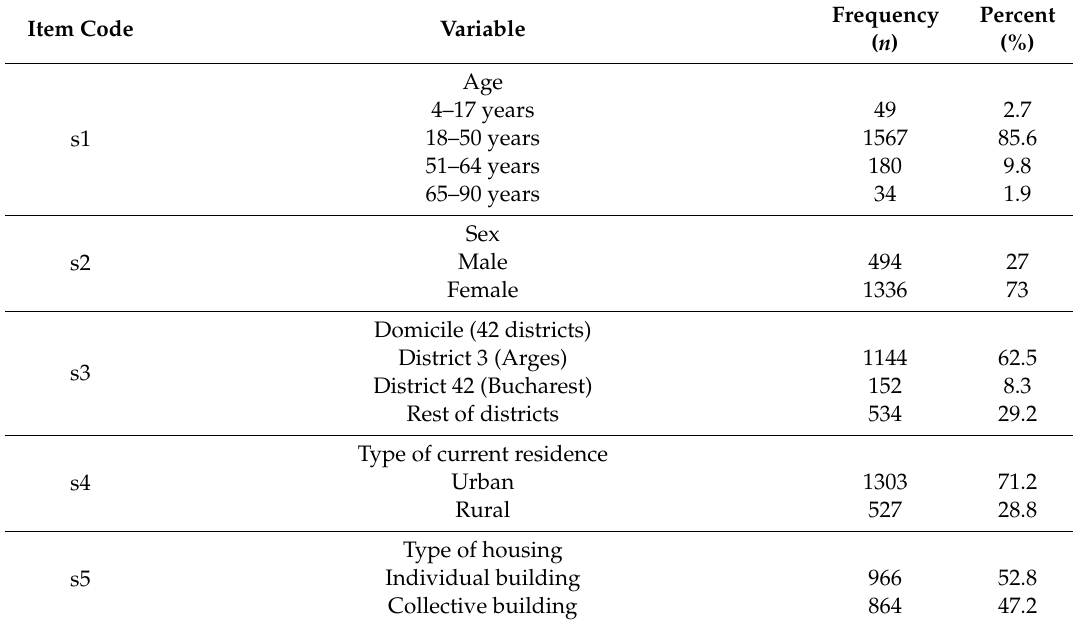
Table 1. Summary of the sociodemographic characteristics of study participants (N =